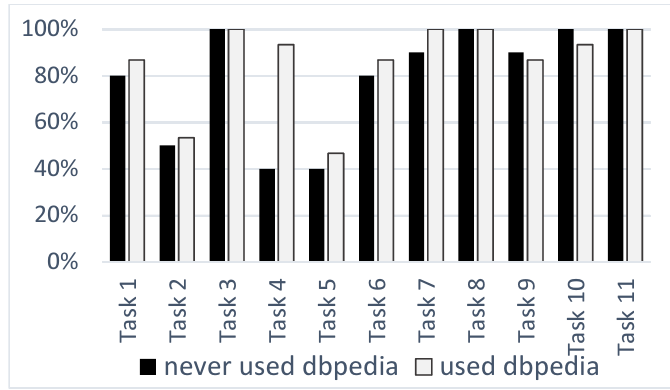
Figure 11. Success rates for experienced and inexperienced